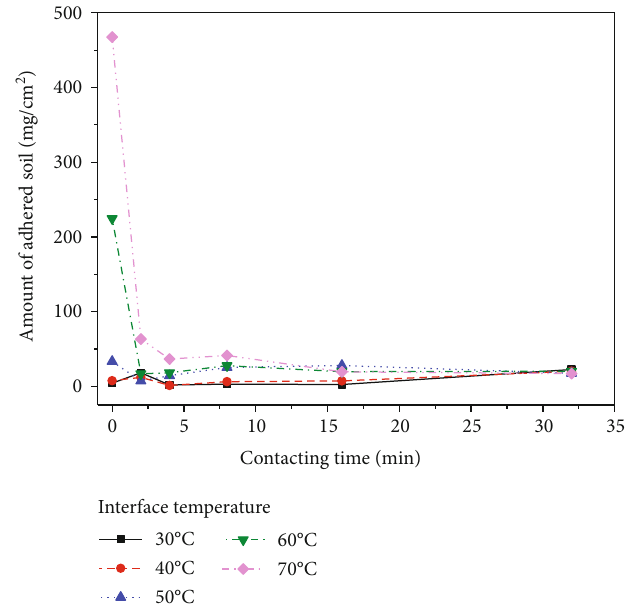
Figure 10: The relationship between the contacting time and the amount of adhered